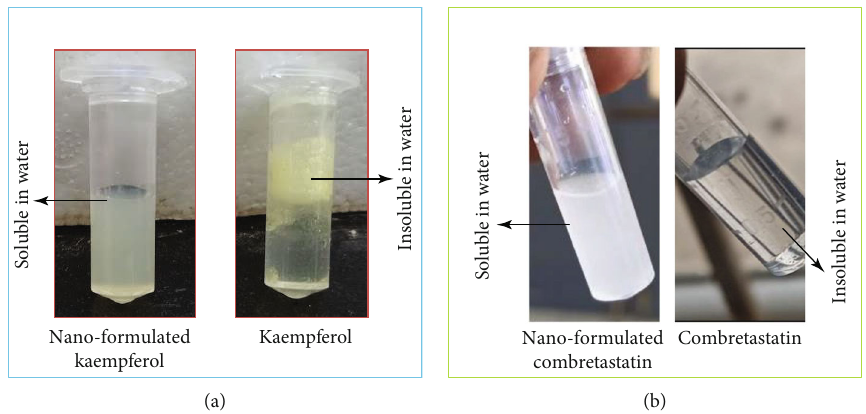
Figure 3: Photographs of drugs suspended in Milli-Q water. (a) Kaempferol and NF-k. (b) Combretastatin and